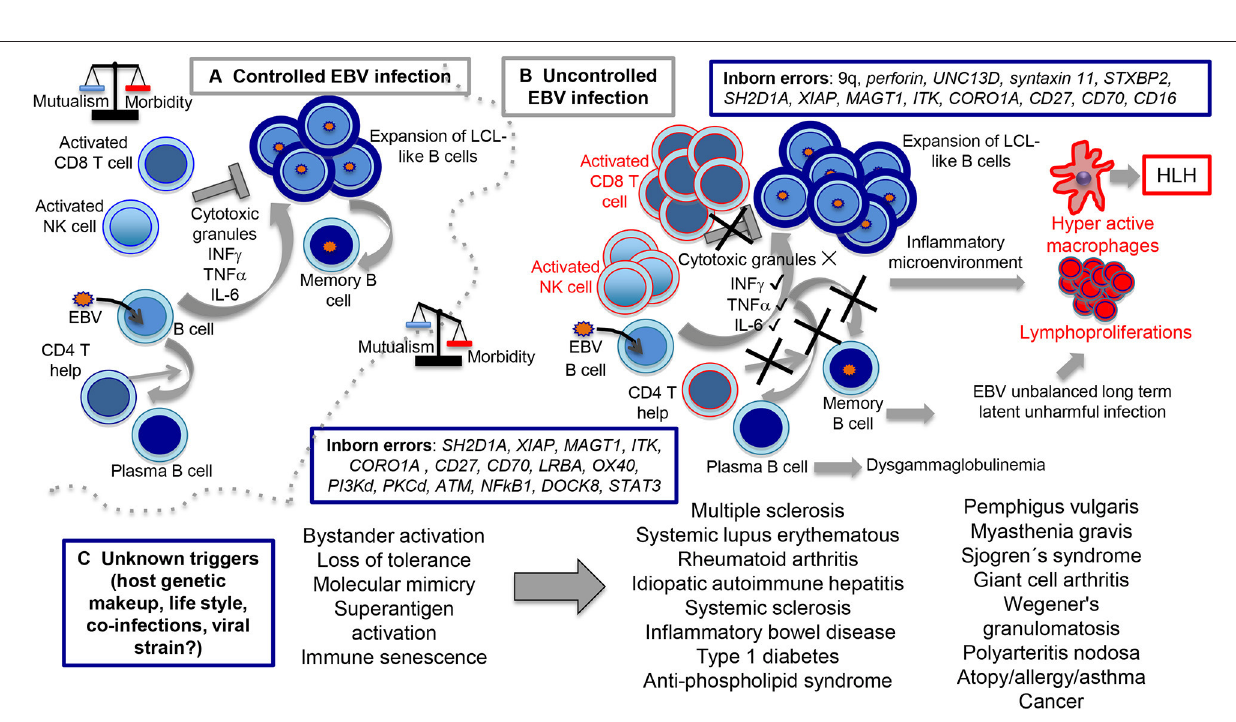
Frontiers in Microbiology |